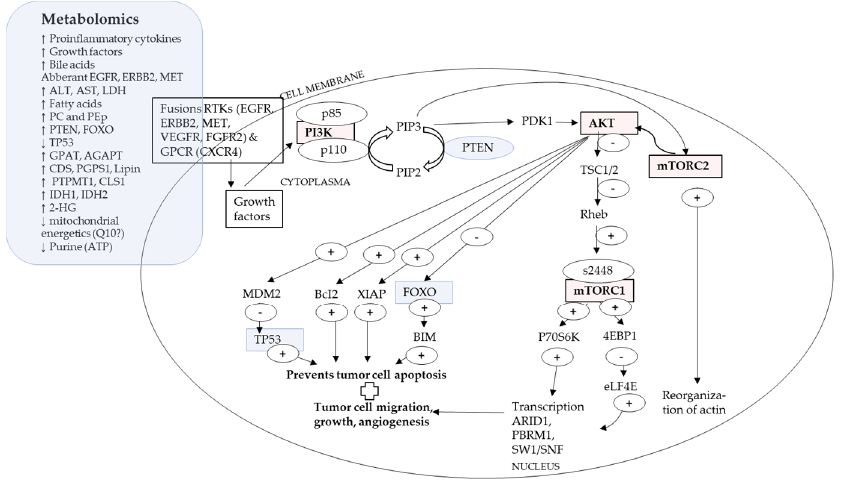
Figure 2. PI3K/AKT/mTOR pathway and metabolomic